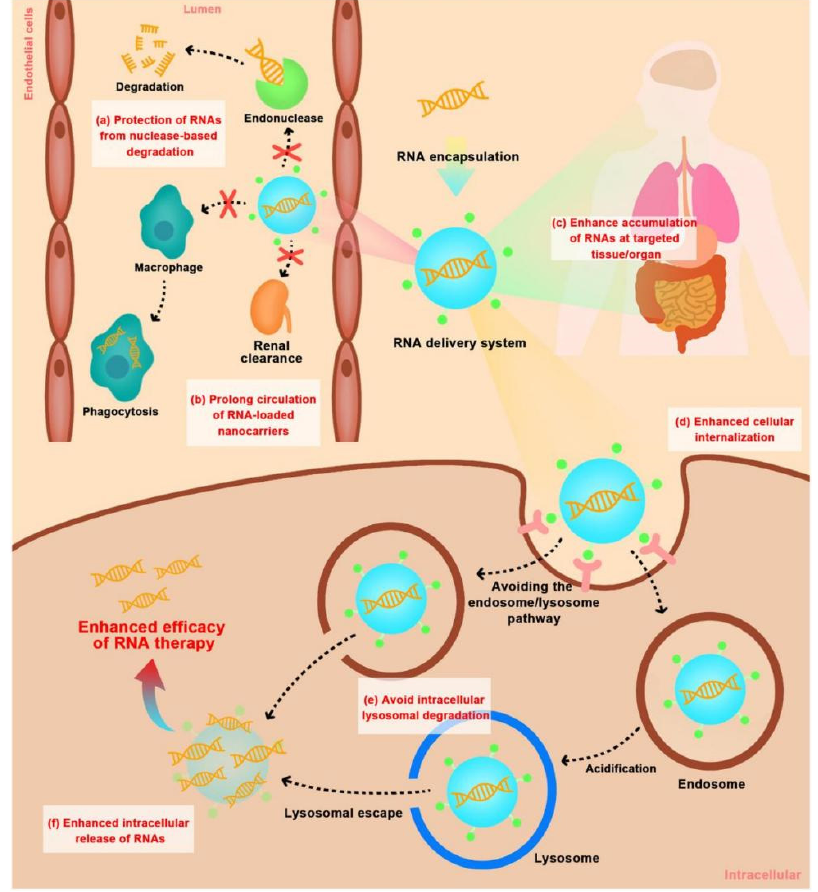
Figure 1. Extracellular and intracellular barriers for in vivo delivery of RNAs using non-viral vectors. (a) protection of RNAs from nuclease-based degradation; (b) prolong circulation of RNA-loaded nanocarriers by avoiding phagocytosis by the mononuclear phagocytic system and rapid kidney clearance; (c) enhance tissue/organ-selective accumulation of RNAs; (d) enhance cellular internalization; (e) avoid intracellular lysosomal degradation; (f) enhance the intracellular release of RNAs. Reprinted with permission from Ref. [34]. 2022, Elsevier.